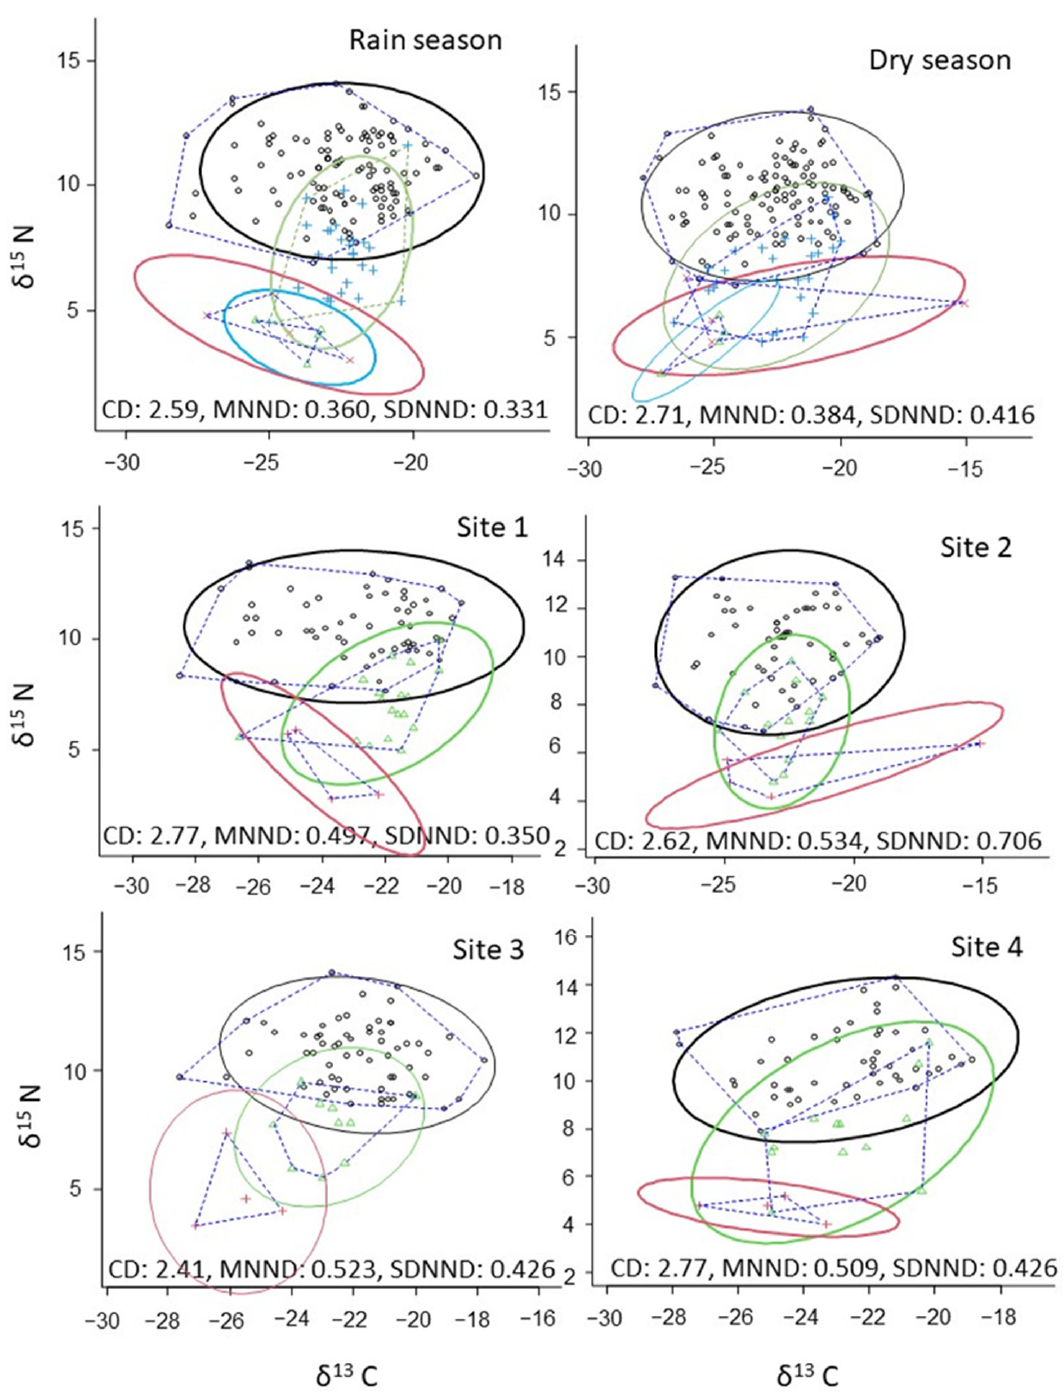
Figure 5. Stable isotope ellipses encircling one standard deviation of the bivariate data for fish species (black line), macroinvertebrates (green line), phytoplankton (blue line), and zooplankton (red line) collected in Lake Zacapu. Layman metrics for each season and site are shown in the plots; phytoplankton and zooplankton communities per site are shown together (red line). CD mean distance to centroid; MNND mean nearest neighbor distance; SDNND standard deviation of nearest neighbor